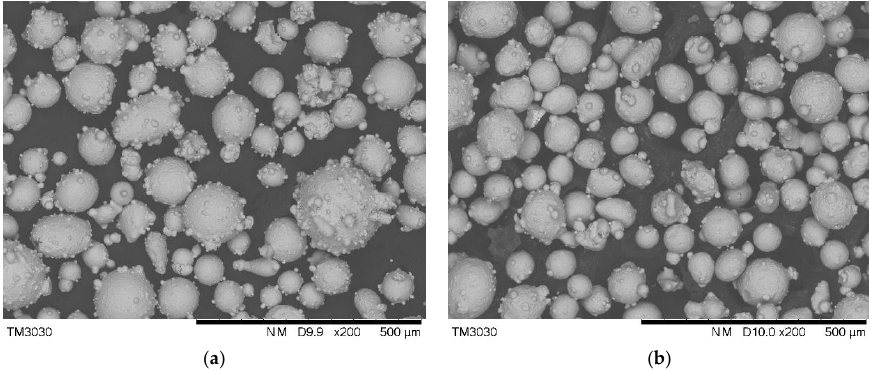
Figure 1. ( a ) Morphology of high speed steel powder; ( b ) Morphology of 304 stainless steel